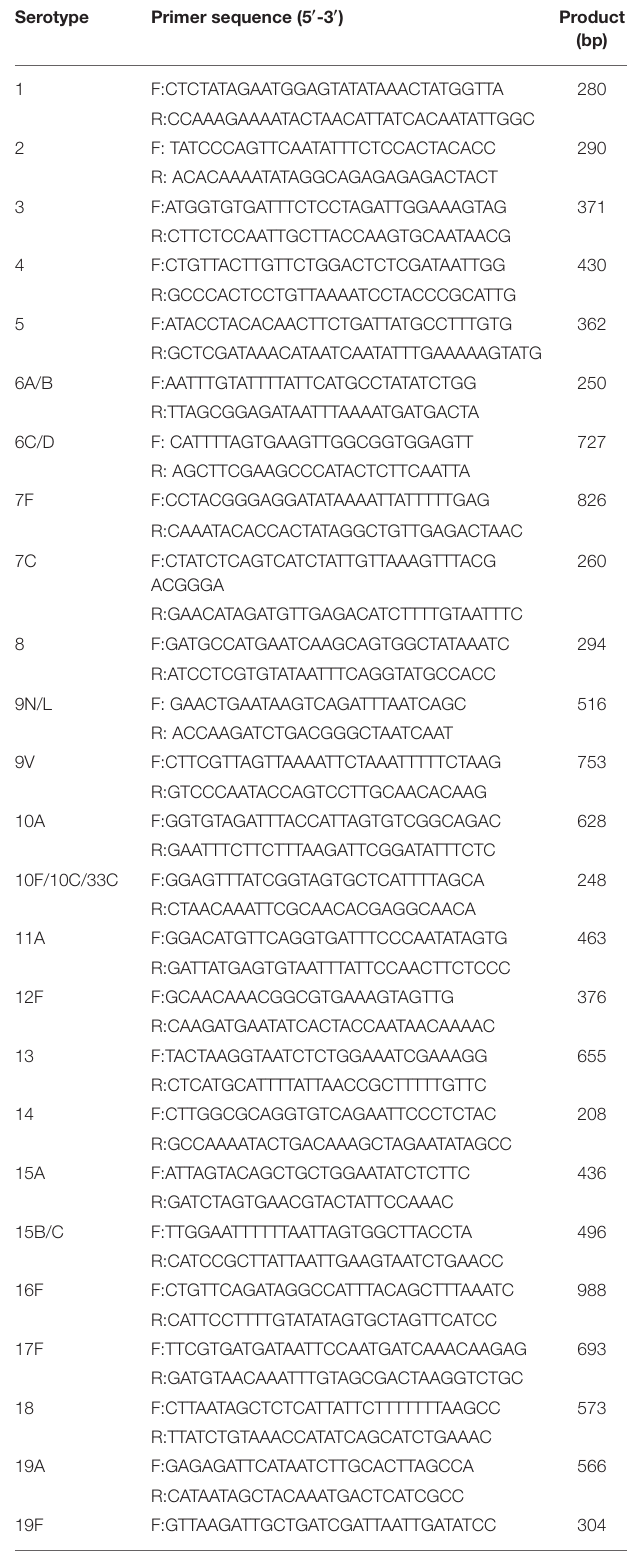
TABLE 1 | Primer pairs of some serotypes in Streptococcus pneumoniae